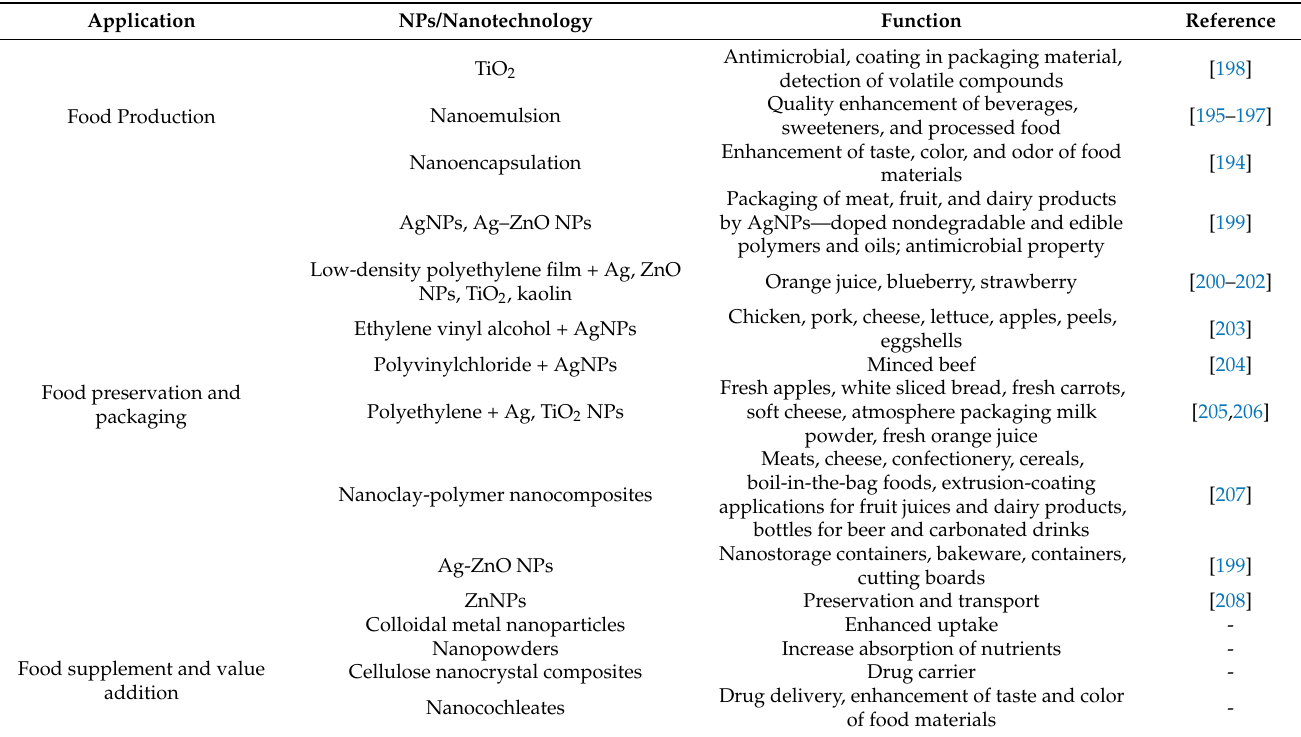
Table 3. Applications of NPs/Nanotechnologies in various aspects of Food Science and Technology.